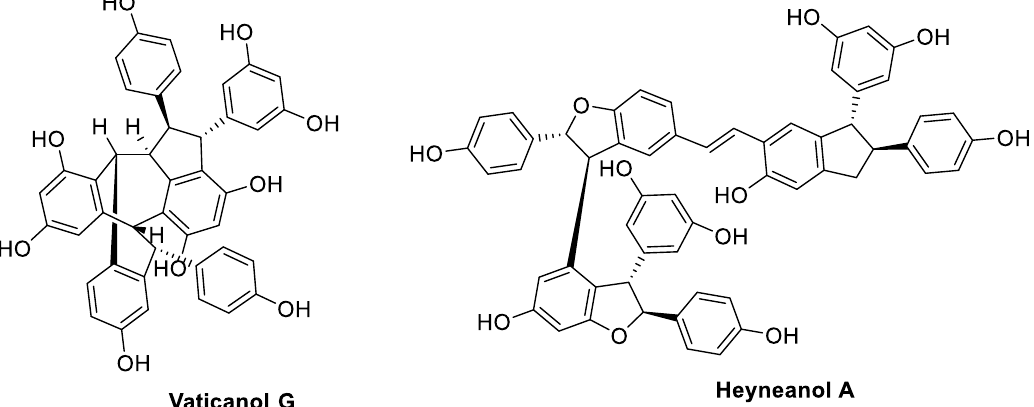
Figure 19. Structures of oligomeric stilbenoids from Shen et al. (2009) [32], Keylor et al. (2015) [100], and Sáez et al. (2018) [101].